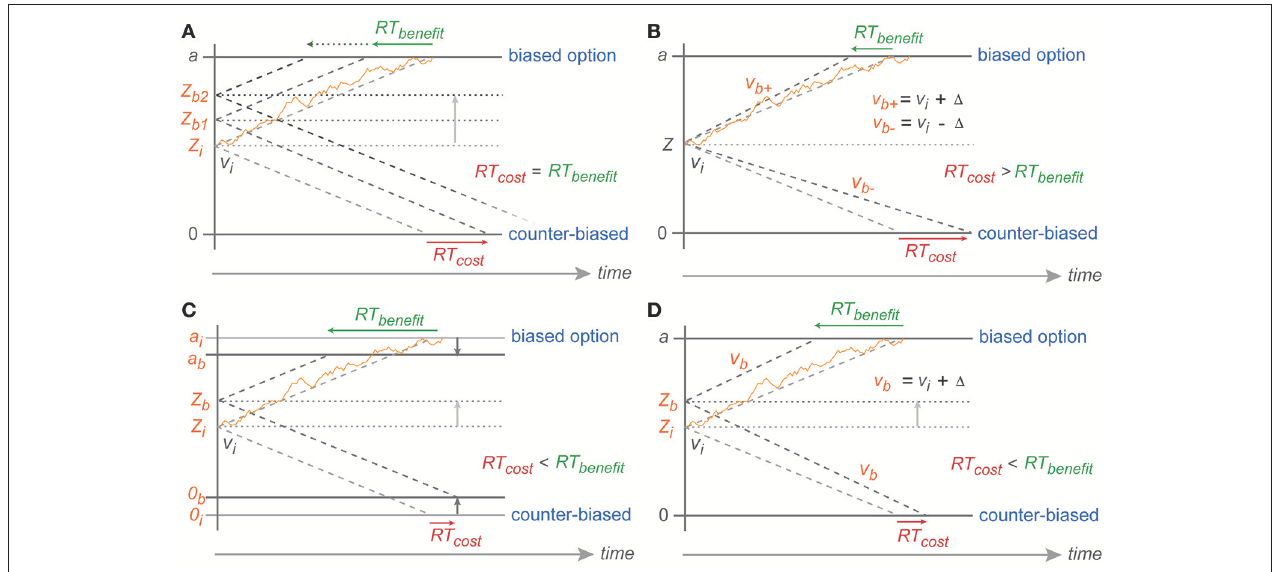
FIGURE 7 | Predicted symmetric effect of baseline shift and asymmetric effect of drift rate change. (A) Baseline shift of the same magnitude should result in symmetric RT cost-benefit whereas (B) RT shortening toward biased reach goal due to drift rate increase ( v b + ) (from the neutral drift rate: v i ) should be smaller than RT cost toward counter-biased reach goal due to drift rate decrease (v b − ) of the same magnitude ( 1 ). Partial boundary lowering (C) and drift rate increase (D) explanations for asymmetric cost-benefit RTs in instructed reaches. 0, a, v, Z represent counter-biased boundary, biased boundary, drift rate, and baseline, respectively. The subscript i indicates initial parameters in absence of any bias (non-biased trials) whereas subscript b represents parameters in case of bias with higher number depicting higher degree of bias and + vs. − depicting parameters toward biased vs. counter-biased boundaries, respectively.